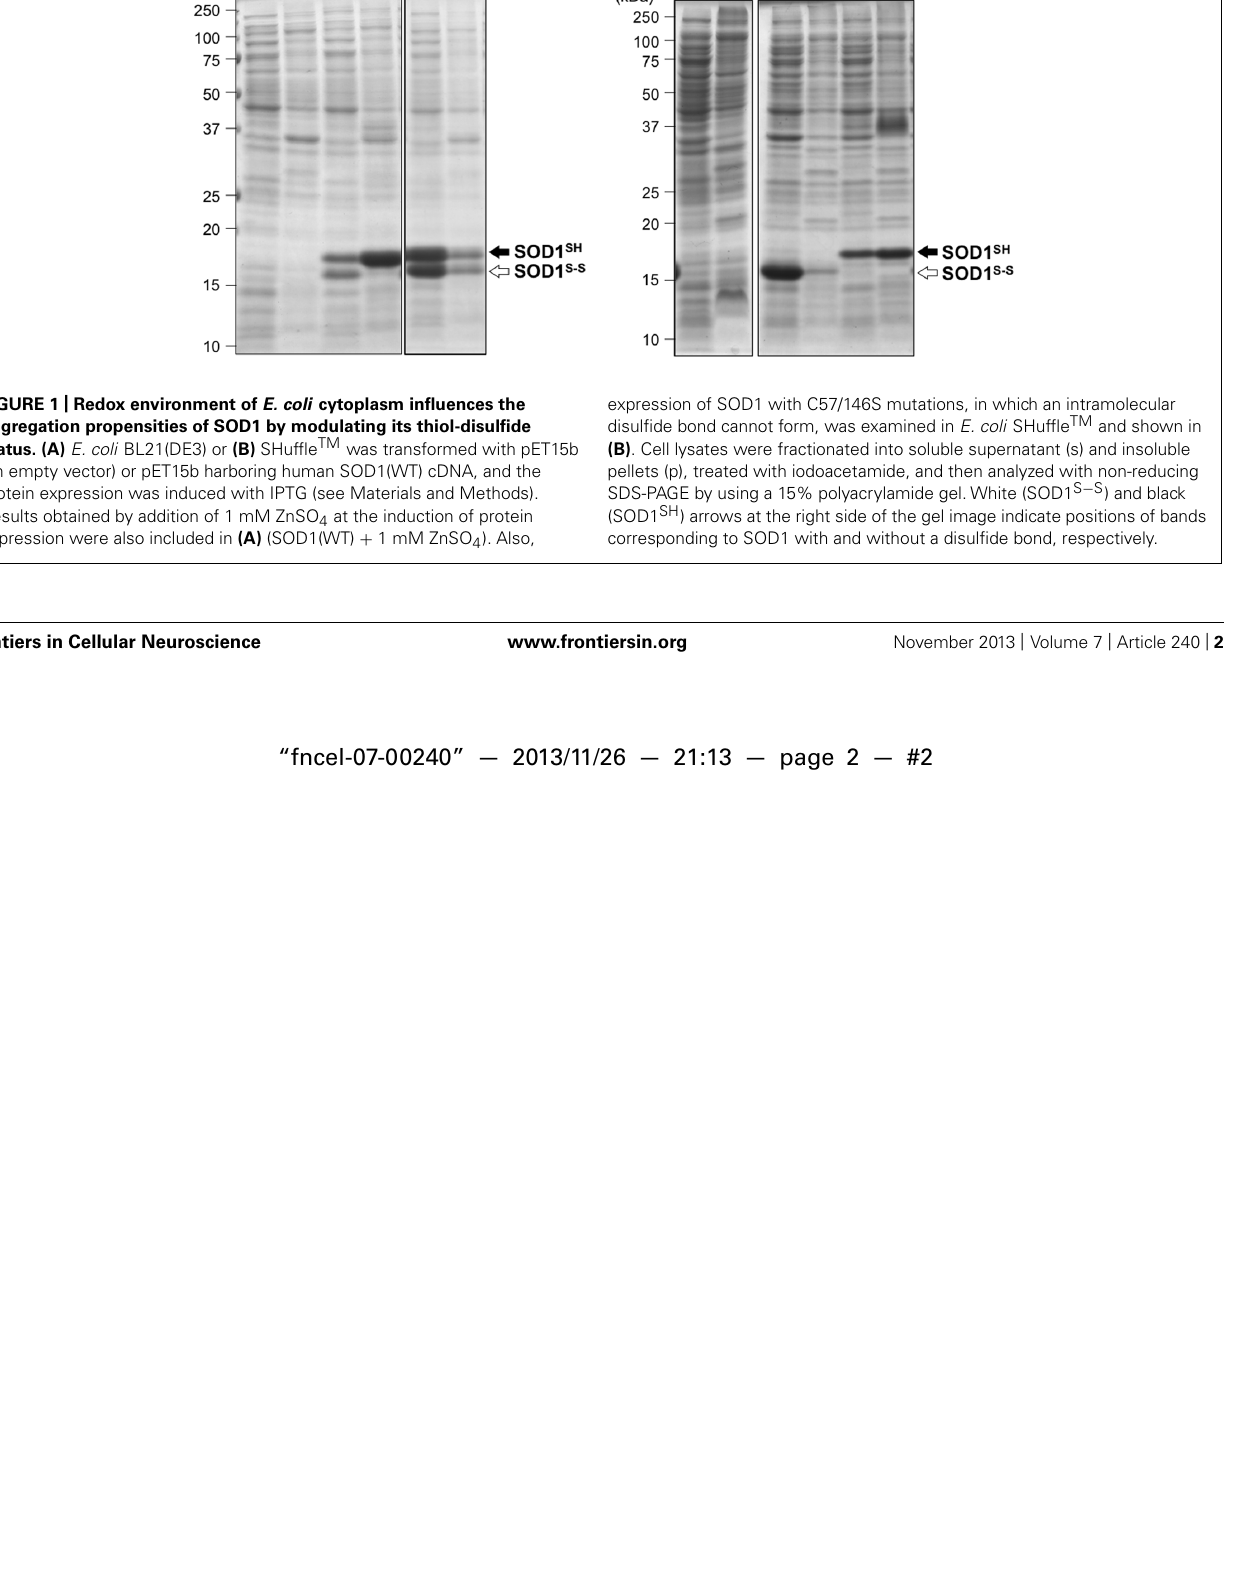
FIGURE 1 | Redox environment of E. coli cytoplasm influences the aggregation propensities of SOD1 by modulating its thiol-disulfide status. (A) E. coli BL21(DE3) or (B) SHuffle TM was transformed with pET15b (an empty vector) or pET15b harboring human SOD1(WT) cDNA, and the protein expression was induced with IPTG (see Materials and Methods). Results obtained by addition of 1 mM ZnSO 4 at the induction of protein expression were also included in (A) (SOD1(WT) + 1 mM ZnSO 4 ). Also,